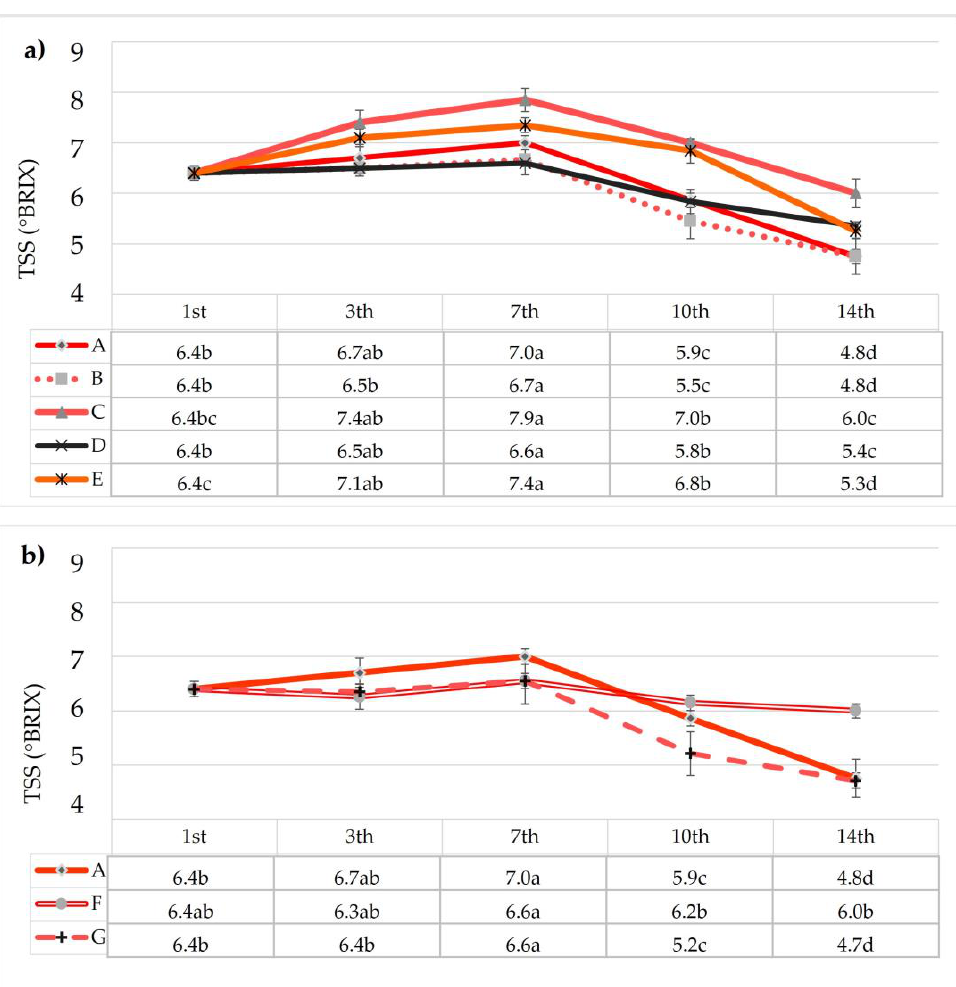
Figure 5. Effects of edible coatings enriched with AE ( a ) and BEO ( b ) on total soluble solids (TSS) of strawberries during storage. Small letters within a column show a significant difference as assessed by Tukey’s post hoc test.